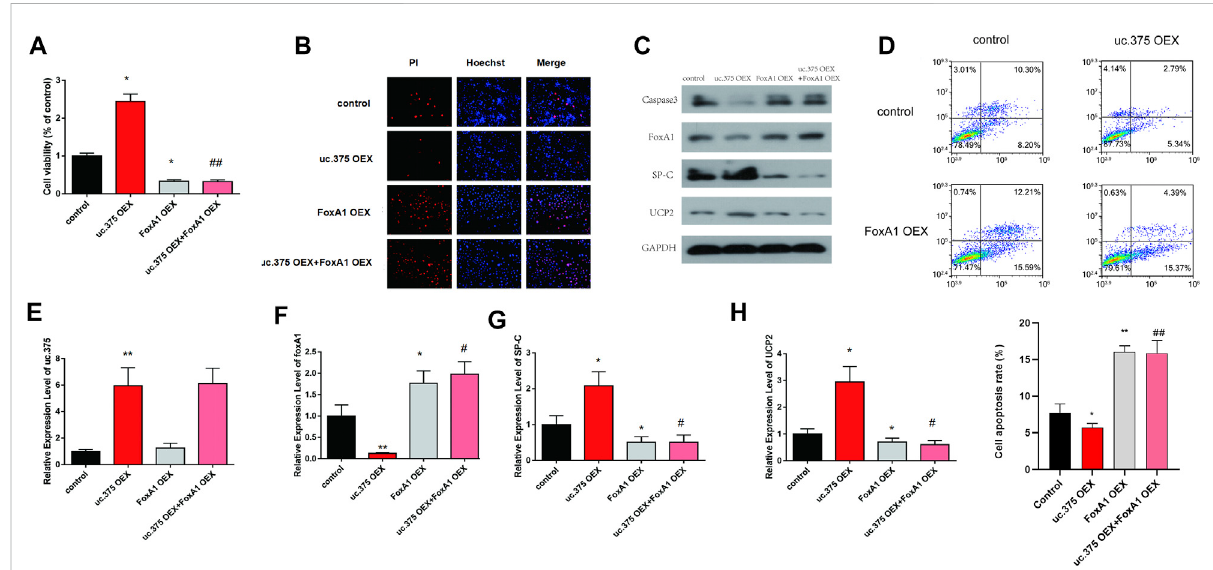
FIGURE 5 Effects of uc.375 overexpression and FoxA1 overexpression on the function of MLE 12 cells. (A) The proliferation activity of MLE 12 cells was detectedbyCCK-8assay. (B) ThecellapoptosiswasdeterminedbyHoechst/PIstaininginMLE12cells. (C) Theproteinlevelsofcaspase3,FoxA1,SP- CandUCP2wereinvestigatedbywesternblotinMLE12cells. (D) ThecellapoptosiswasdeterminedusinglowcytometryassayinMLE12cells. (E-H) The relative mRNA expression levels of uc.375, FoxA1, SP-C and UCP2 were detected by qRT-PCR in MLE 12 cells. * p < 0.05, ** p < 0.01 vs control. # p < 0.05, ## p < 0.01 vs uc.375